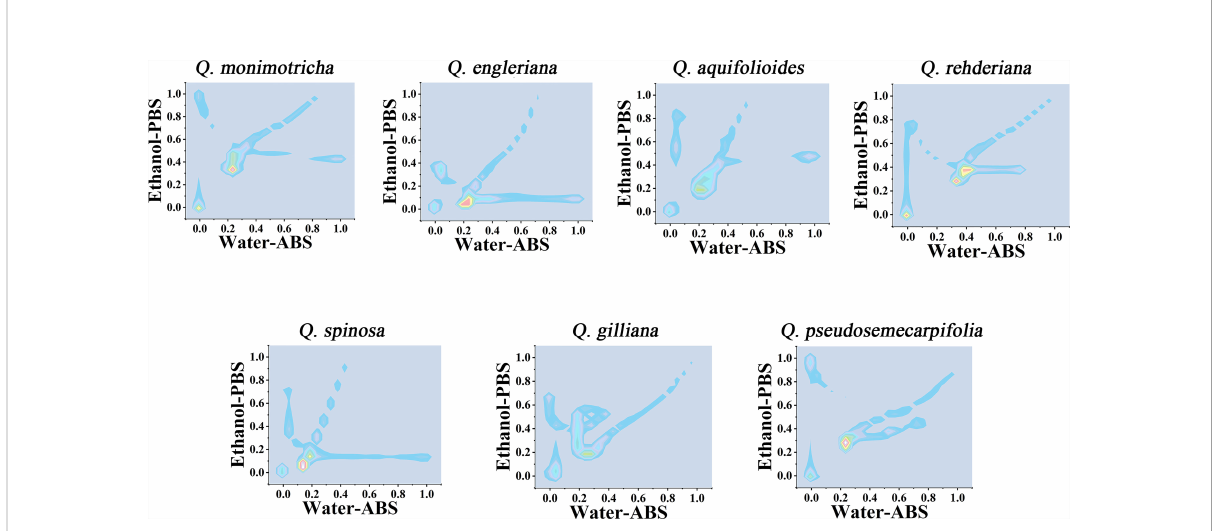
FIGURE 4 Two-dimensional density map of Q. monimotricha, Q. engleriana, Q. aquifolioides, Q. rehderiana, Q. spinosa, Q. gilliana and Q. pseudosemecarpifolia combining the signals collected under ABS for the water extracts and under PBS for the ethanol